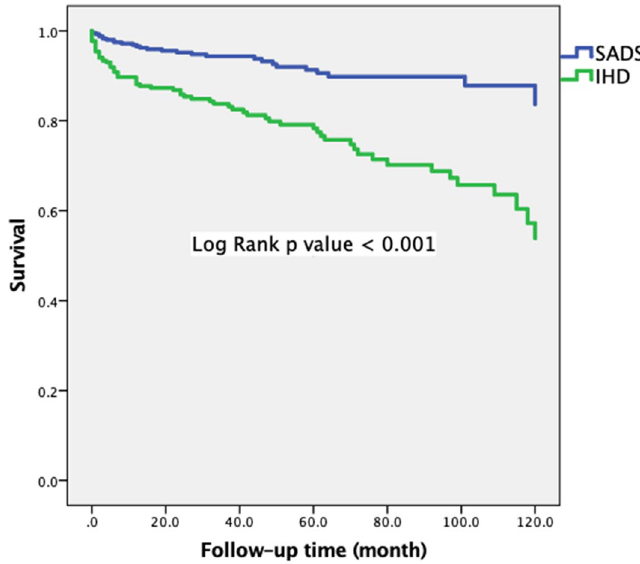
Figure 1. Kaplan–Meier curve according ischemic heart disease.